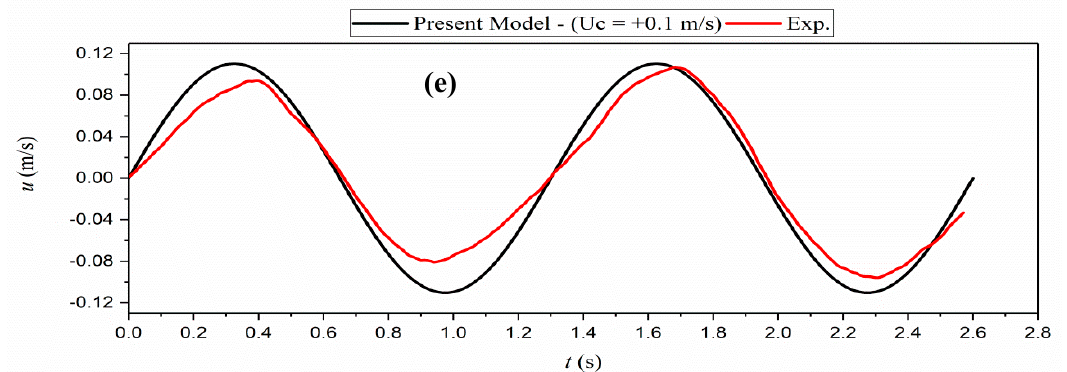
Figure 14. Time series of velocity for T =1.3 s, H =0.05 m, U c =0.1 m/s; W =160%; ( a ) 0.02 m; ( b ) 0.05 m; ( c ) 0.085 m; ( d ) 0.12 m; ( e ) 0.135 m above the rigid bed.